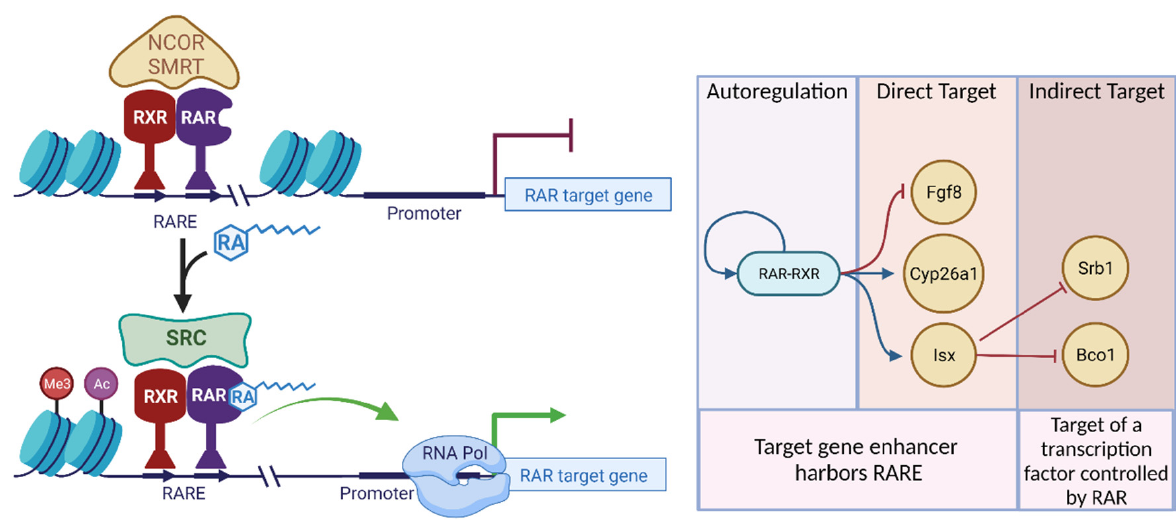
Figure 1. Transcriptional mechanism of RAR-RXR. RAR-RXR binds RARE element found in enhancer regions of target genes. Binding of RA to RAR-RXR causes the dissociation of co-repressors such as NCOR/SMRT and associated HDAC enzymes, and the recruitment of co-activators such as SRC which include HAT and histone methylase enzymes. Conversely, binding RA allows for ligand-induced repression of certain targets by RAR. Chromatin opening allows the initiation of transcription by RNA polymerases. RAR-RXR can control the expression of its own encoding genes (Rara, Rarb, Rarg) or direct target genes that harbor a RARE. Many retinoid-responsive genes are also controlled indirectly via intermediary RA-responsive transcription factors. Created with BioRender.com (accessed on 16 February